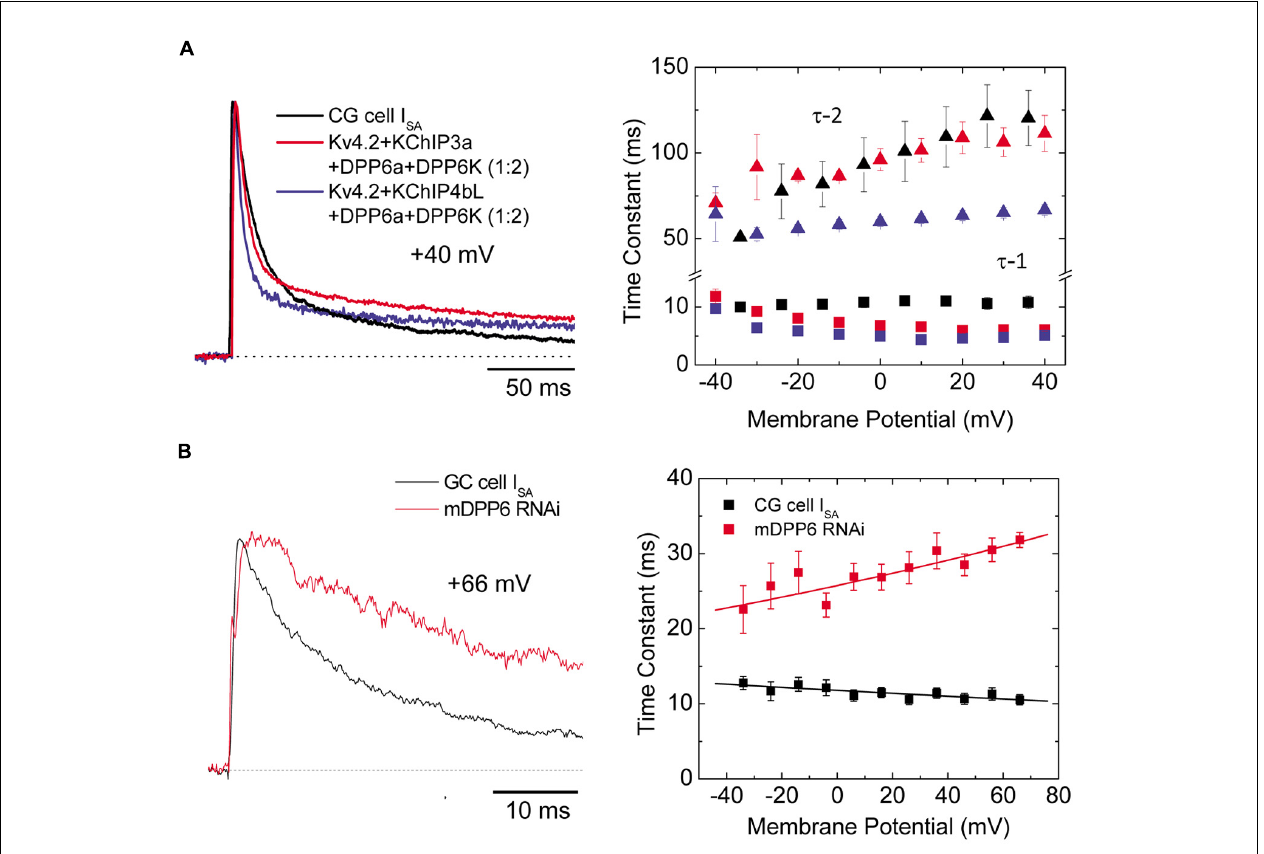
FIGURE 7 |Ternary channel complex consisting of Kv4.2, KChIP3a, DPP6a, and DPP6K express A-type current similar to I SA from CG cells (Adapted from Nadin and Pfaffinger, 2010; Jerng and Pfaffinger, 2012). (A) Comparison between native I SA from CG cells and reconstituted currents expressed by Kv4.2, KChIP, and DPP6 subunits. Based on real-time RT-PCR results, the ratio between DPP6a and DPP6K was determined to be 1-to-2 (Jerng and Pfaffinger, 2012). Native and reconstituted current traces elicited by + 40 mV depolarizations are quite similar (left panel). The incorporation of KChIP3a verses KChIP4bL produces negligible effect on